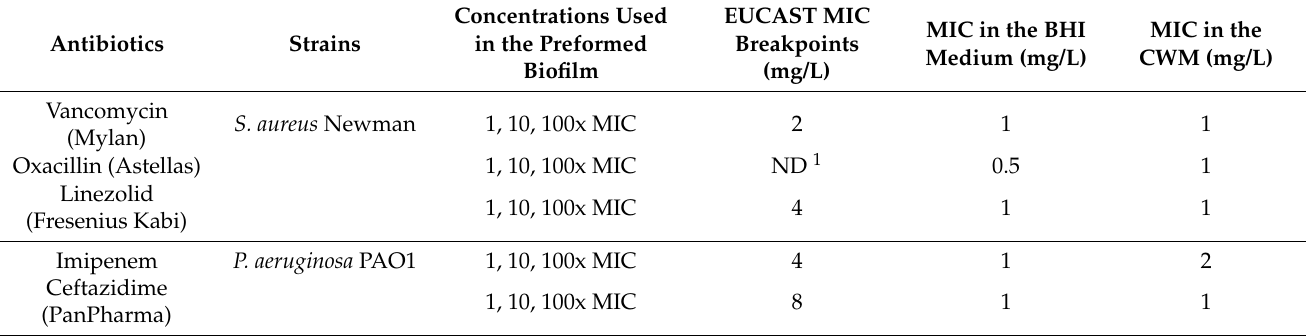
Table 3. Antibiotics used and minimum inhibitory concentration determined in the